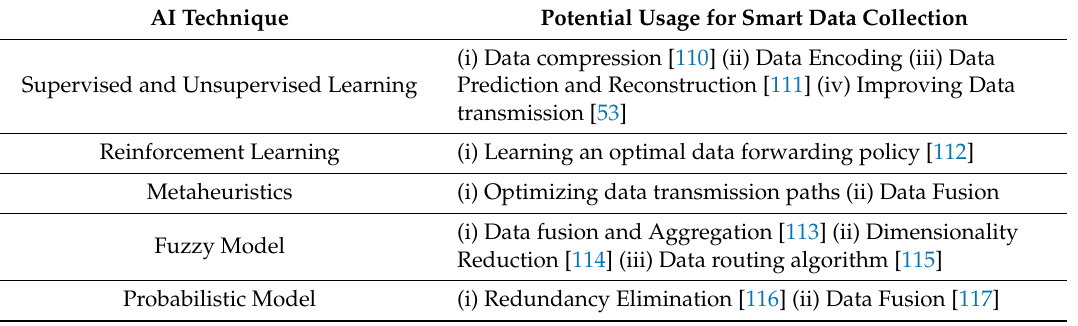
Table 5. Summary of the usage of AI in IoT smart data